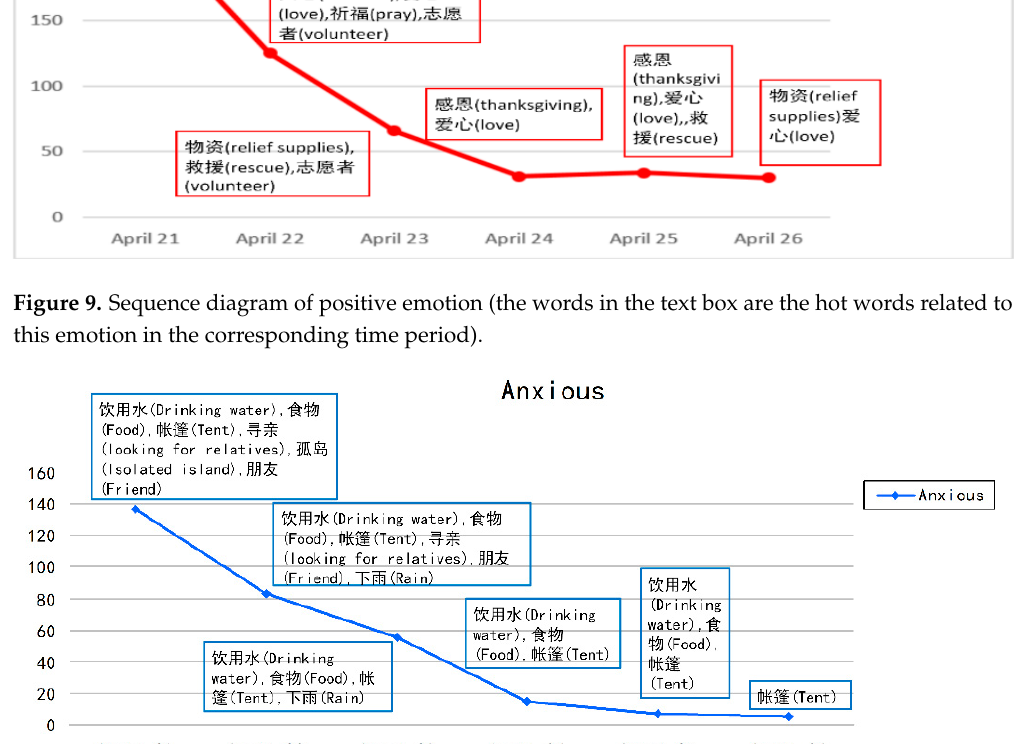
Figure 10. Sequence diagram of anxiety.